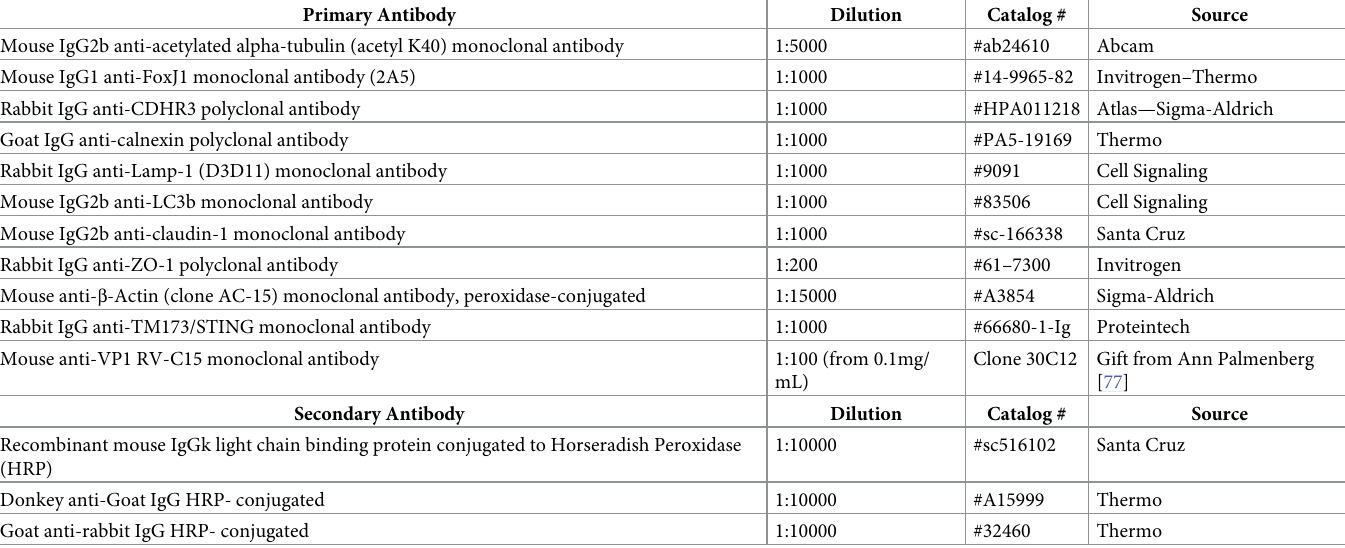
Table 3. Primary and secondary antibodies used in immunoblotting assays. Primary